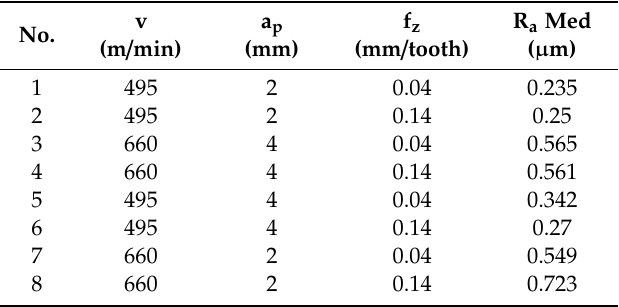
Table 7. R a med measurements according to the Taguchi design.